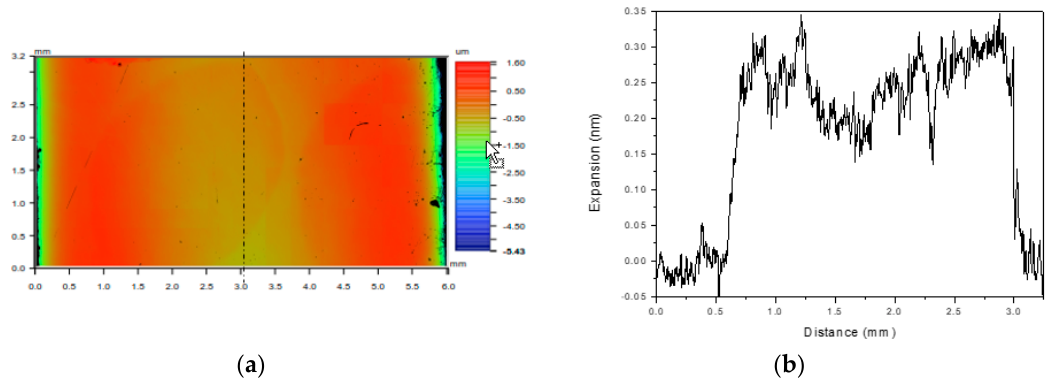
Figure 3. Image of spots at the surface of the glass ( a ) and its surface profile ( b ) using Wyko NT1100 optical profiling system.